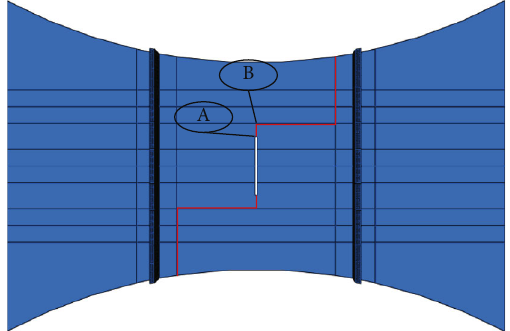
Figure 13: The path of damage propagation in the three-stringer panel that was obtained from experimental data